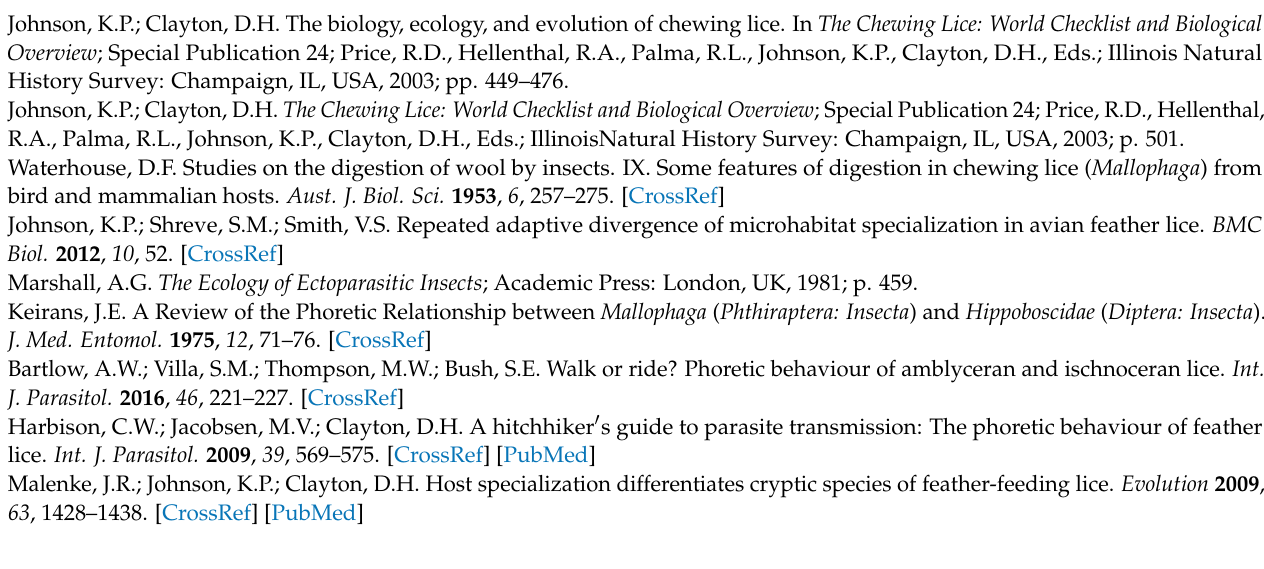
Figure S4: Bayesian phylogeny of combined mitochondrial (COI gene) and nuclear gene (18S). Figure S5: Bayesian phylogeny of combined mitochondrial (COI gene) and nuclear gene (EF-1 α ). Table S1: Louse sequences obtained from GenBank. Table S2: Louse specimens used in analysis from South Texas. Table S3: Avian species sampled for lice in south